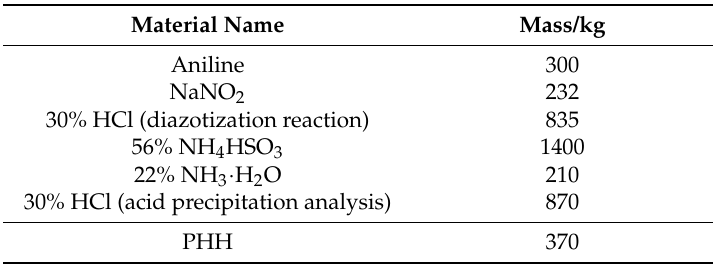
Table 3. Mass of raw materials and product.